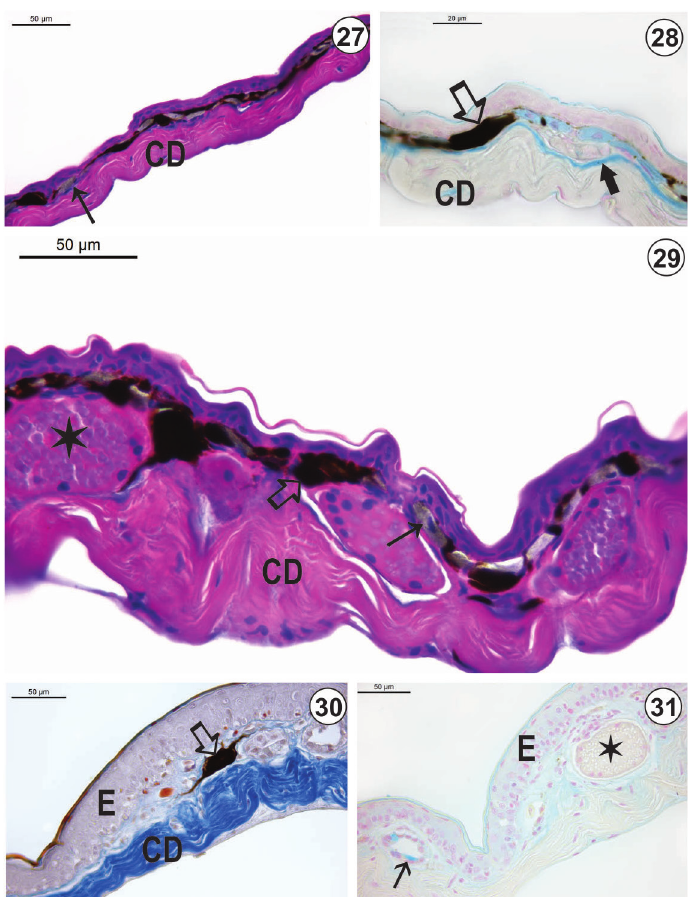
Figures 27–31. Light micrograph of the integument of O. humilis : (27) Dorsal region (HE-staining); (28) Dorsal region (AB-method); (29) Ventrolateral region (HE-staining) (30) Ventral region (Mallory´s trichrome staining); (31) Ventral region (AB-method). In the dorsal region, the spongious dermis is poorly developed. Melanophores ( _ ) are visualized in all integument regions; however, iridophores ( → ) are visualized only in both dorsal and ventrolateral integument. Both pigment cells are located just beneath the epidermis. Alcianophilic reaction is observed in cytoplasm of iridophores as well as in the EK-layer ( Æ ) of the dorsal integument. The EK-layer is absent in the ventral integument. Apocrine glands with heterogeneous content ( ¬ ) occur in both ventrolateral and ventral integument. In S. humilis , mixed glands ( Ú ) are visualized in the ventral region, being formed by serous and mucous cells. Mucous cells exhibit alcianophilic reaction. E = epidermis; CD = compact